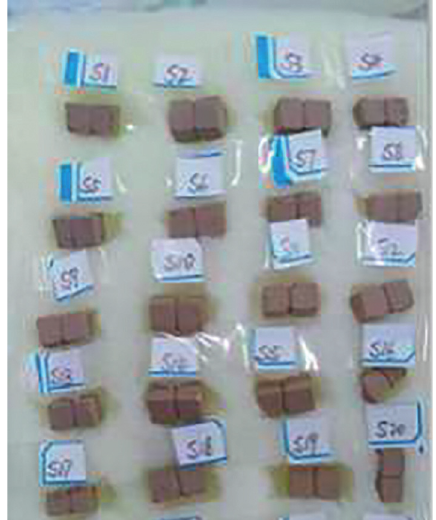
Figure 5: Samples of the scanning electron microscope test. Table 3: Soil-water characteristic curve test values for compacted loess.